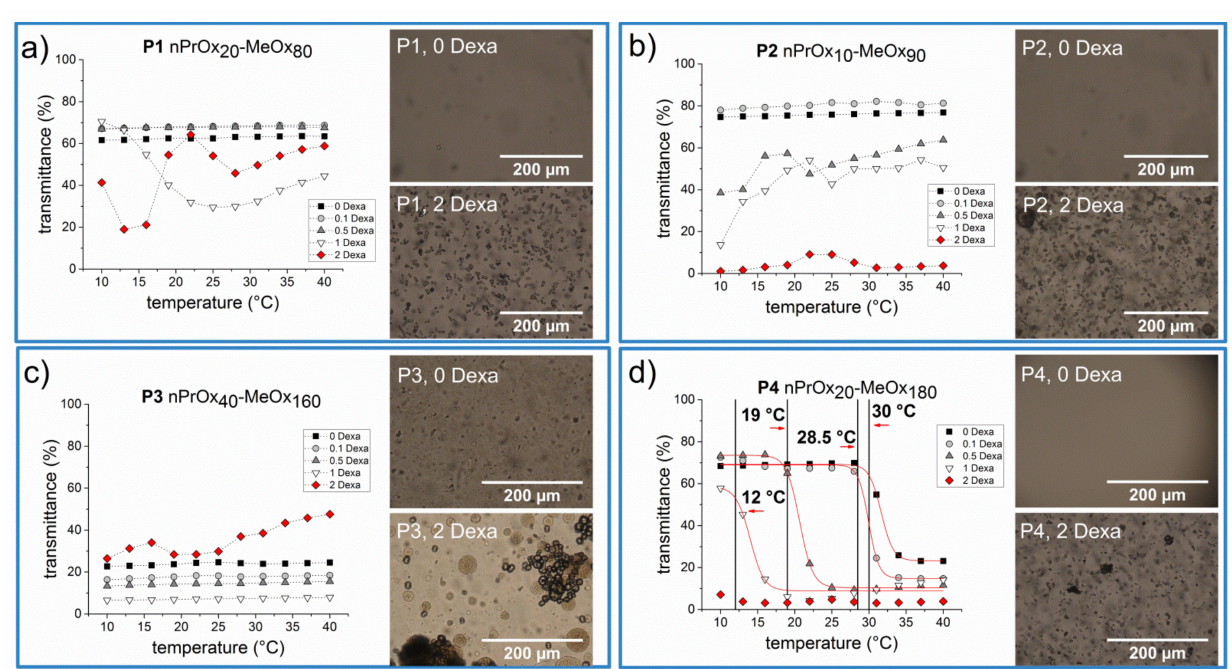
Figure 2. Thermoresponsive behavior of P1 ( a ), P2 ( b ), P3 ( c ), P4 ( d ) copolymers (10 mg · mL − 1 in PBS) with various concentrations of Dexa (0, 0.1, 0.5, 1, 2 mg · mL − 1 ) measured by UV/Vis spectrometry. The red solid line represents Boltzmann fit, T cp values were calculated as 90% transmittance from Boltzmann fits. The black dashed lines serve as visual guidance. Images from the optical microscope represent samples without Dexa and with 2 mg · mL − 1 Dexa after UV/Vis measurement, captured after cooling to